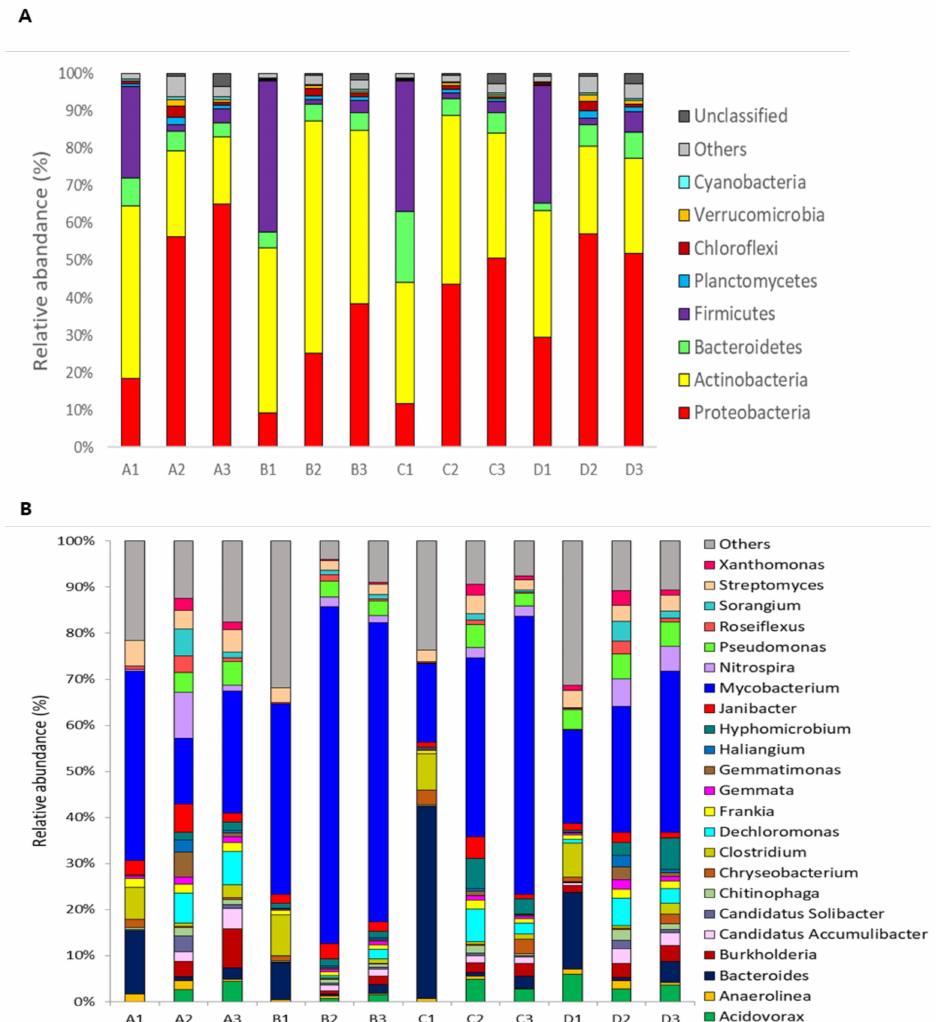
Figure 4. Relative abundance and taxonomic identification of bacteria at the phylum ( A ) and genus levels ( B ) in the small (A, B) and large (C, D) WWTP samples. A1, B1, and C1 indicate influent samples, A2, B2, and C2 indicate activated sludge samples, and A3, B3, C3 indicate effluent samples. Samples with a relative abundance <1% were classified as